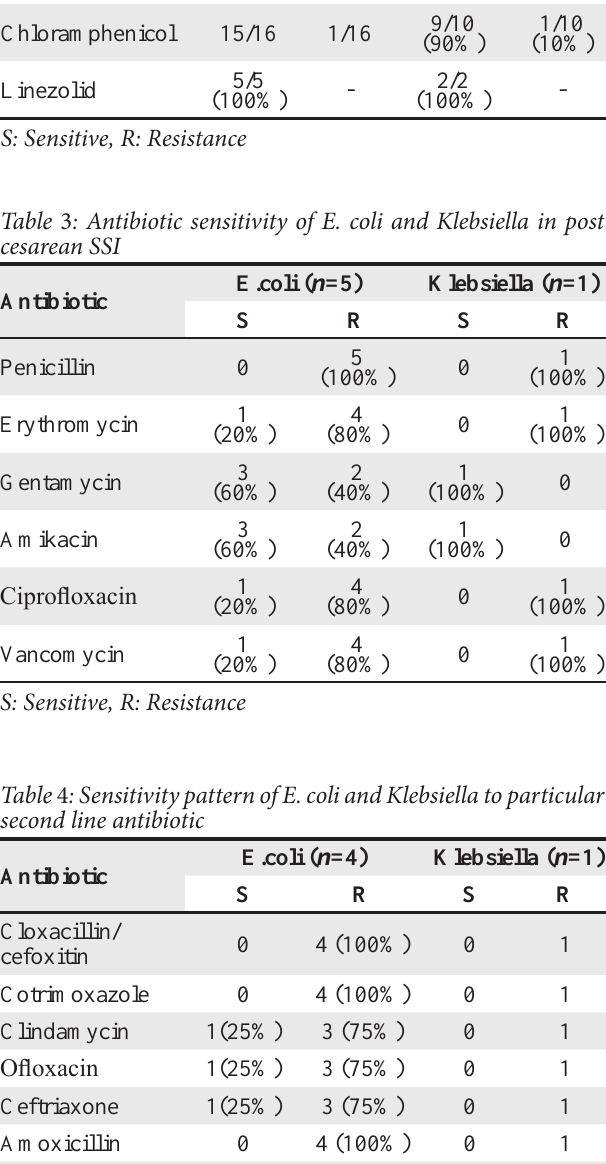
Table 2 : Antibiotic sensitivity of Staphylococcus aureus to selective second line drugs Staph. aureus MRSA Antibiotics